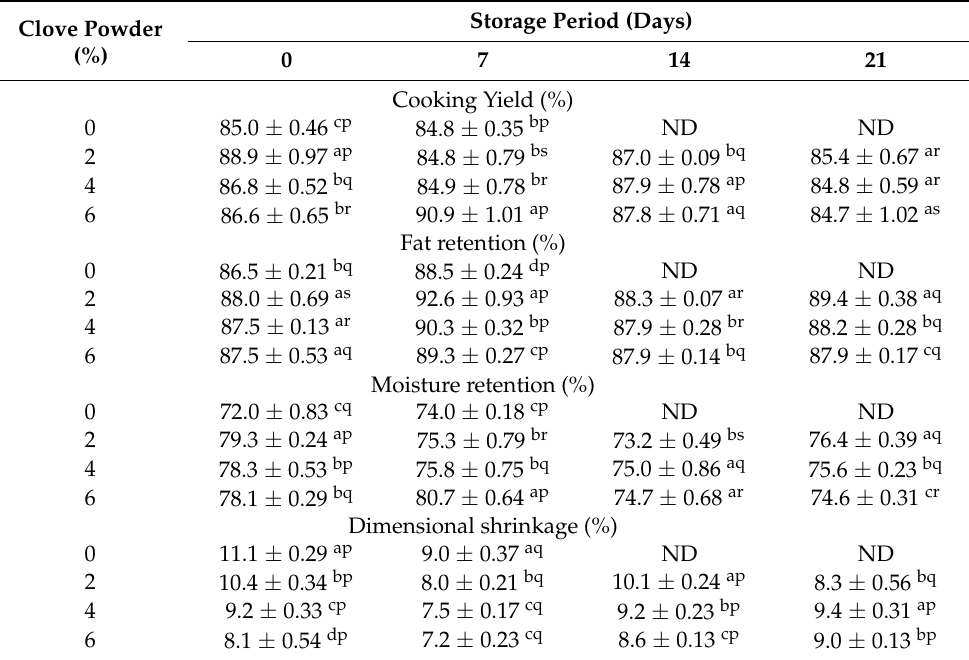
Table 2. Cooking characteristics of beef burger formulated with different concentrations of clove powder during storage at 4 ◦ C ( ±